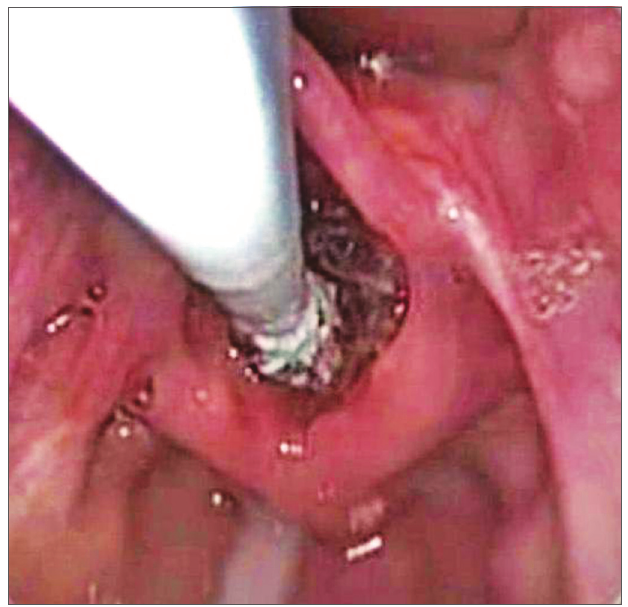
Figura 2. Laringoscopia direta com óptica de zero grau mostrando cateter sendo introduzido na laringe, com o balão